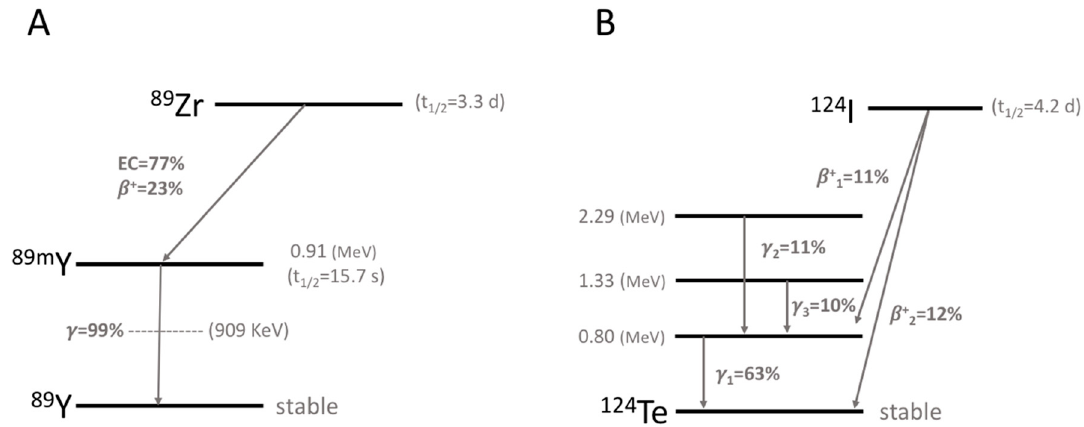
Figure 1. Radioactive decay scheme for 89 Zr ( A ) and 124 I ( B ).